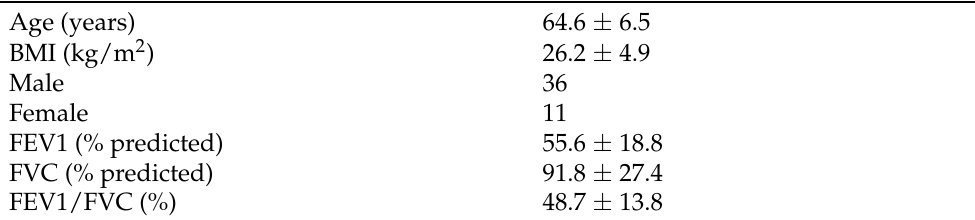
Table 1. Demographics of the chronic obstructive pulmonary disease (COPD) patients. FEV1: forced expiratory volume in one second. FVC: forced vital capacity. The data are presented as mean ± standard deviation.